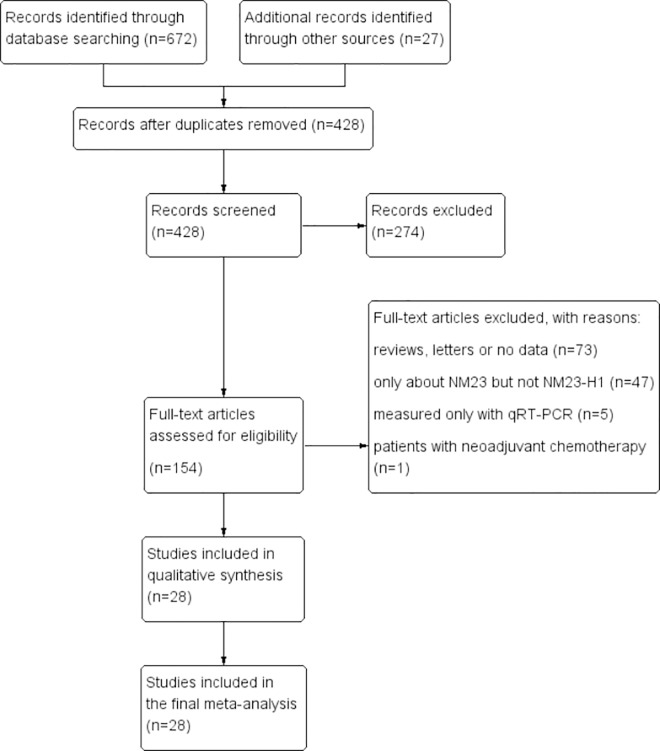
Flow chart for the selection of records to include.